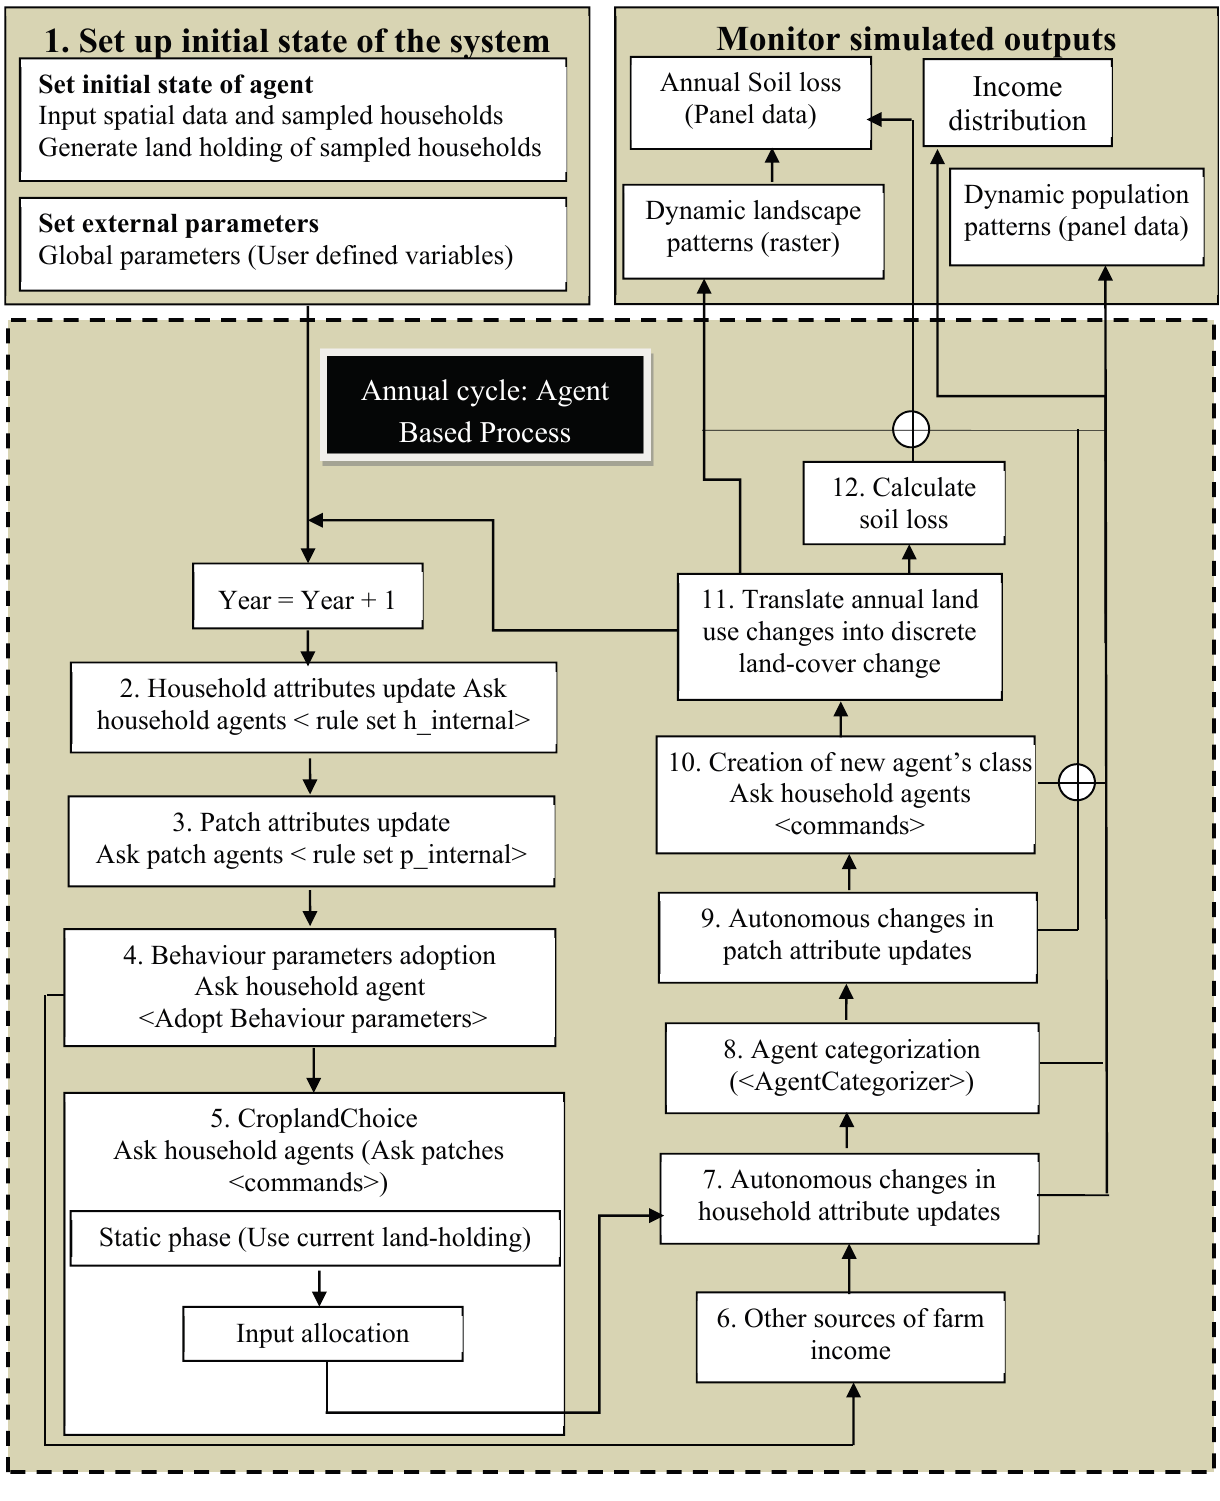
Figure A1. Main simulation steps for Vea-LUDAS (Note: Under the maize credit scenario simulation, step 5 is replaced with Maize credit adoption sub-model; dashes indicate the annual cycle of the agent-based